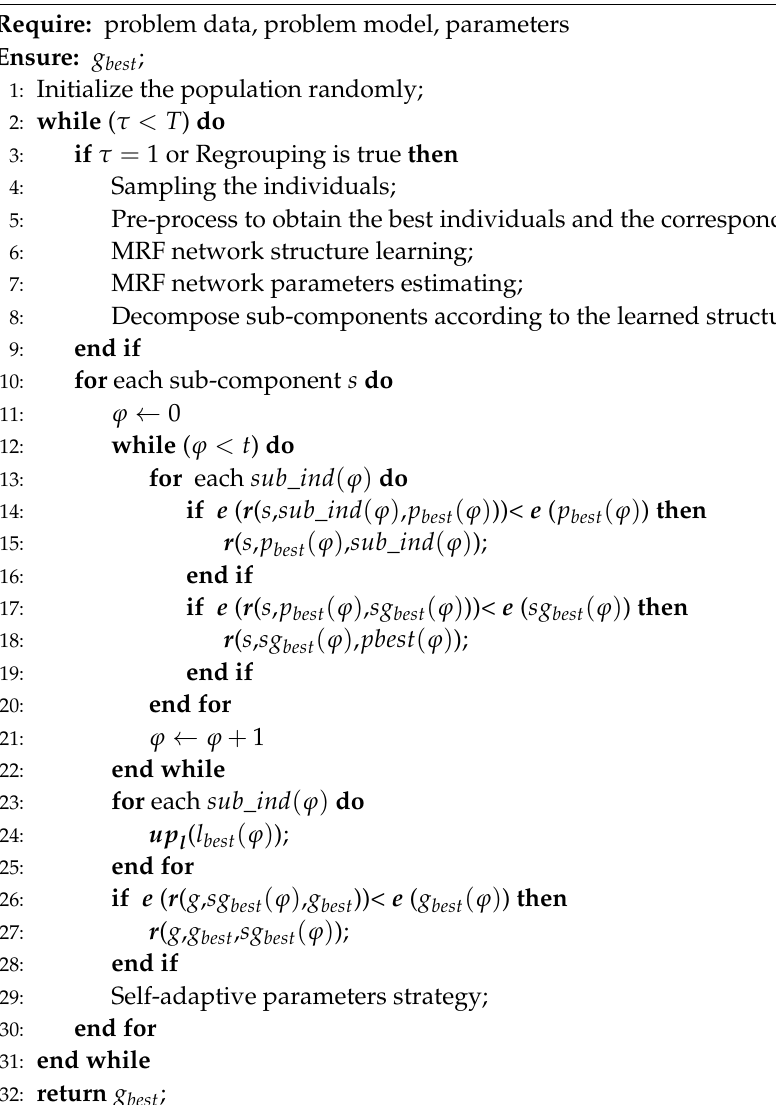
Algorithm 1 The procedure of hCEA-MRF.